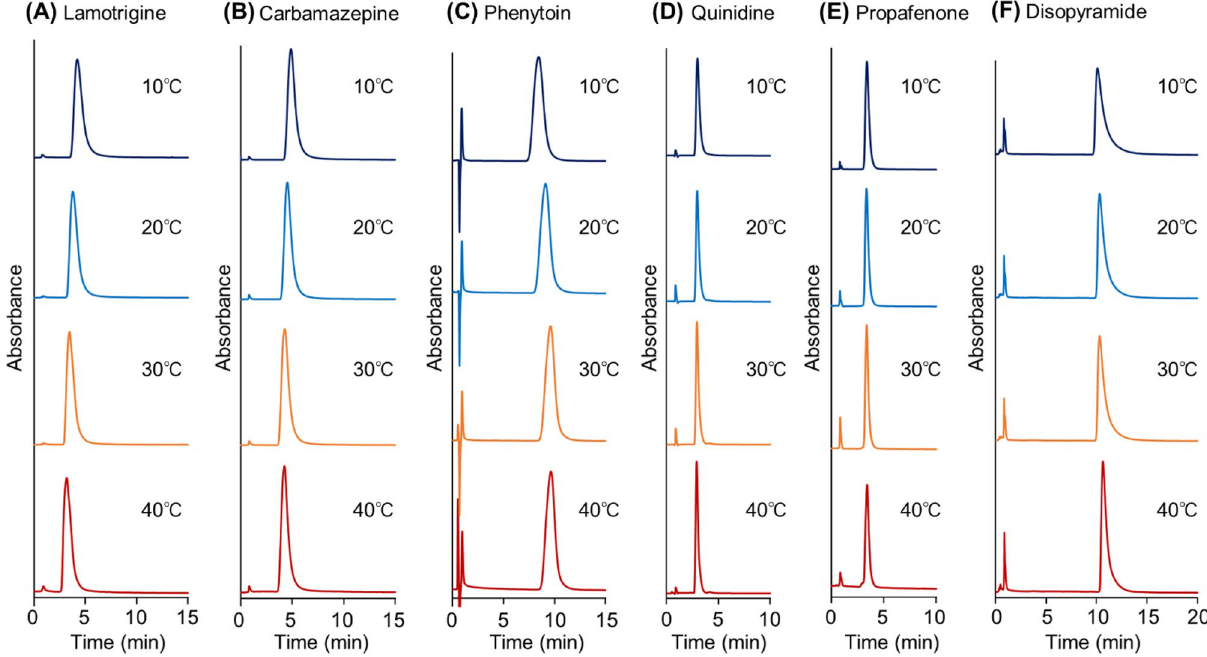
Figure 4. Chromatograms of antiepileptic drugs ( A – C ) and anti-arrhythmic drugs ( D – F ) using crosslinked PNIPAAm modified-bead packed columns. ( A ) Lamotrigine, ( B ) Carbamazepine, ( C ) Phenytoin, ( D ) Quinidine, ( E ) Propafenone, and ( F ) Disopyramide. The mobile phase was 10 mM CH 3 COONH 4 (pH 6.75) buffer solution with a flow rate of 1.0